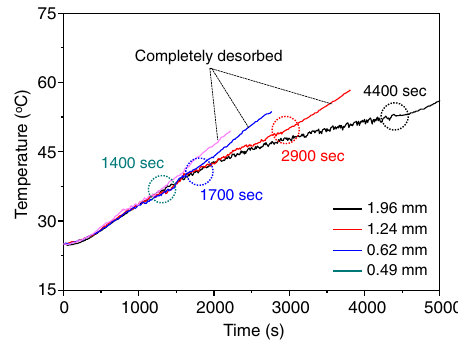
Fig. 5 | Heat dissipation performance of latent cooling in terms of zeolite fi lm thickness. Source data are provided as a Source data fi